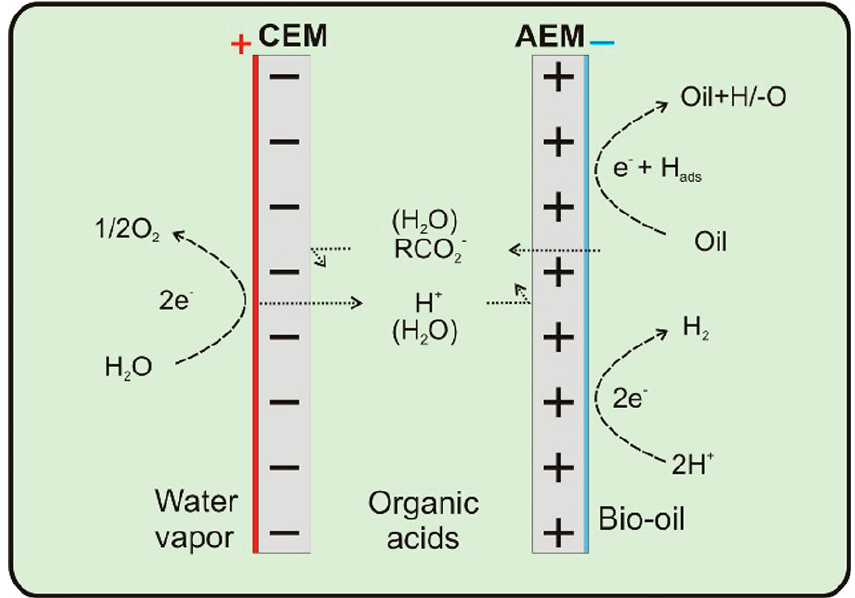
Figure 15. Spatial representation of the dual membrane electrolyzer cell. Reprinted with permission from Reference [153]. Copyright 2018 American Chemical Society.